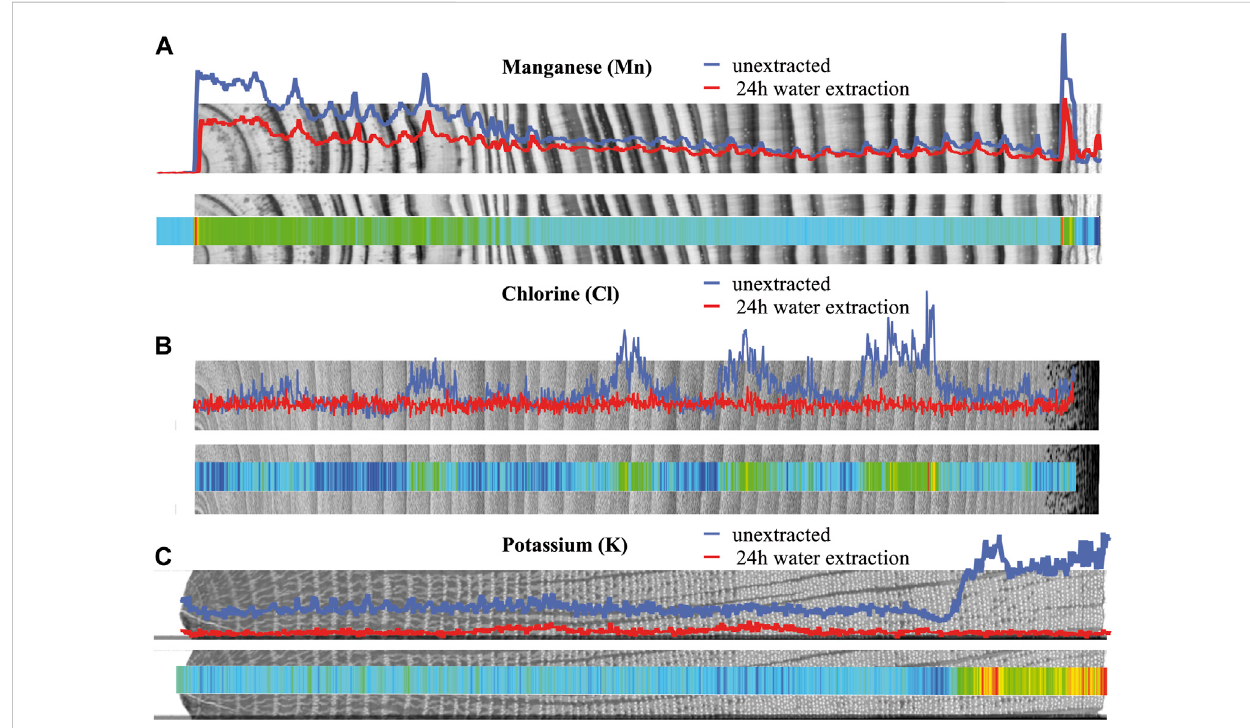
FIGURE 2 Radiographicimagesof (A) apine (B) apoplarand (C) anoaksampleoverlaidwiththetrendsformanganese,chlorineandpotassiumrespectivelyfor the control measurement (blue curve) and after 24 h of Soxhlet extraction in water (red curve). The lower panels show the differences between both curves (i.e., the extracted part) as a heatmap on the same radiograph. For pine the extraction success is higher at the inner heartwood part, for poplar chlorine peaks are more or less completely extracted and oak shows a relatively complete extraction over the whole sample. Darker colours of the radiographs correspond to the denser latewood, lighter colours to the